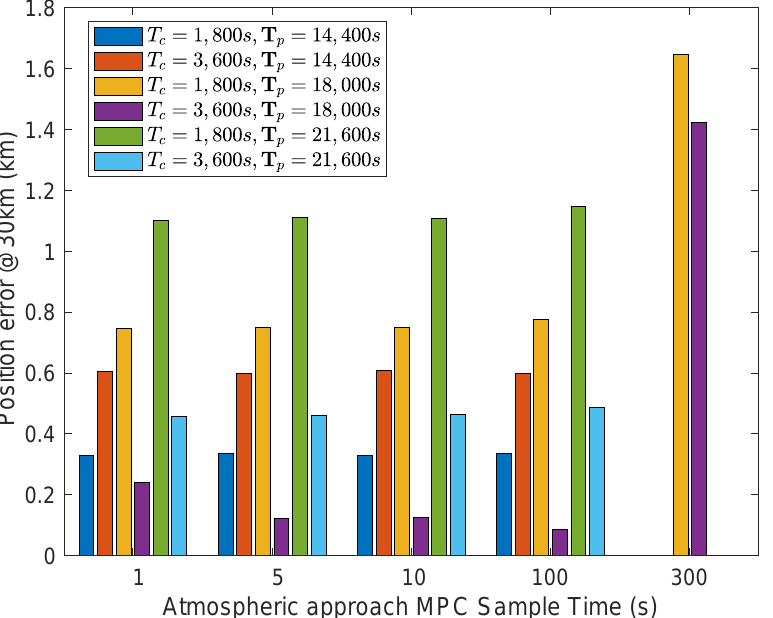
Figure 5. Sensitivity analysis on atmospheric entry MPC sample time. Position error at the altitude of 30 km (TAEM).